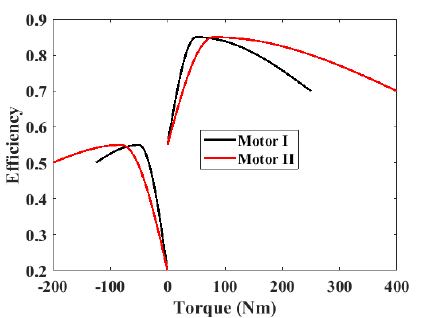
Figure 2. Two designed motor efficiency